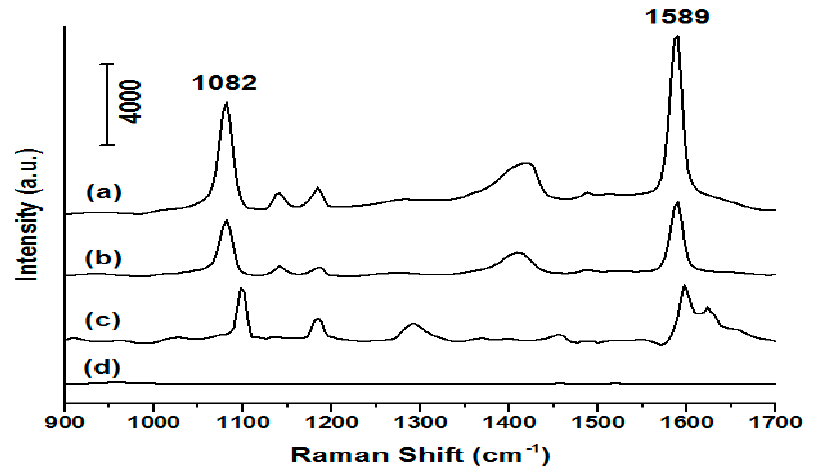
Figure 5. Raman spectra of the mixture of 4-MBA (10 − 5 M) and ( a ) AgNDs (after 48 h of LED irradiation) or ( b ) AgNPs; Raman spectra of ( c ) 4-MBA powder and ( d ) 4-MBA (10 − 4 M).